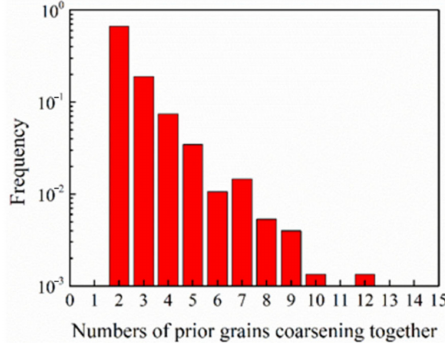
Figure 12. The frequency of number of prior grains coalescing into one grain at a shear strain of